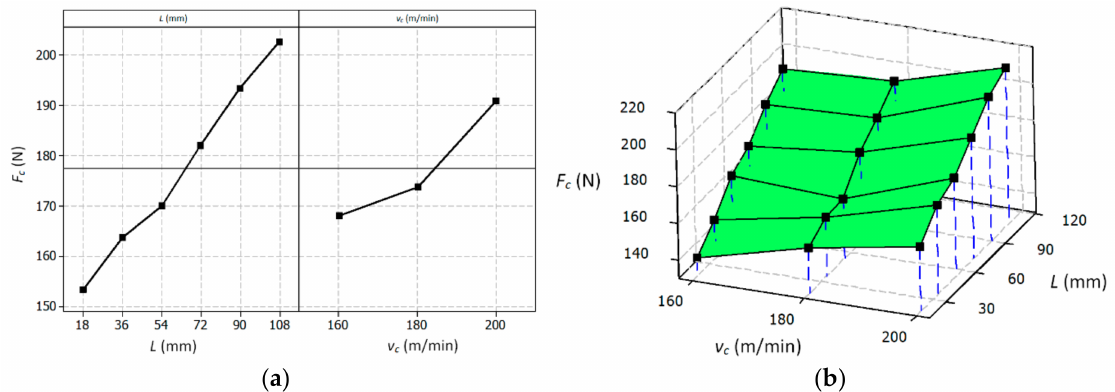
Figure 13. Graphic presentation of the influence of individual variables on the mean value of the total cutting force Fc , main effect plot ( a ), surface plot ( b ).